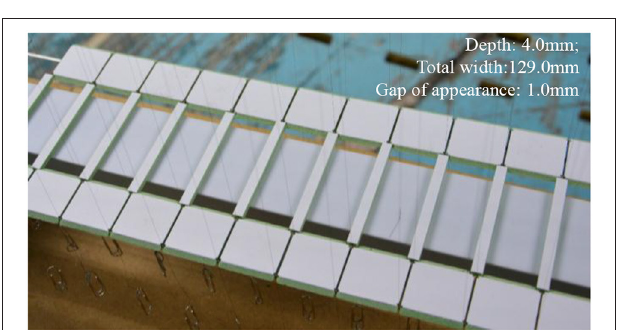
FIGURE 10 | Constraints at pylon.